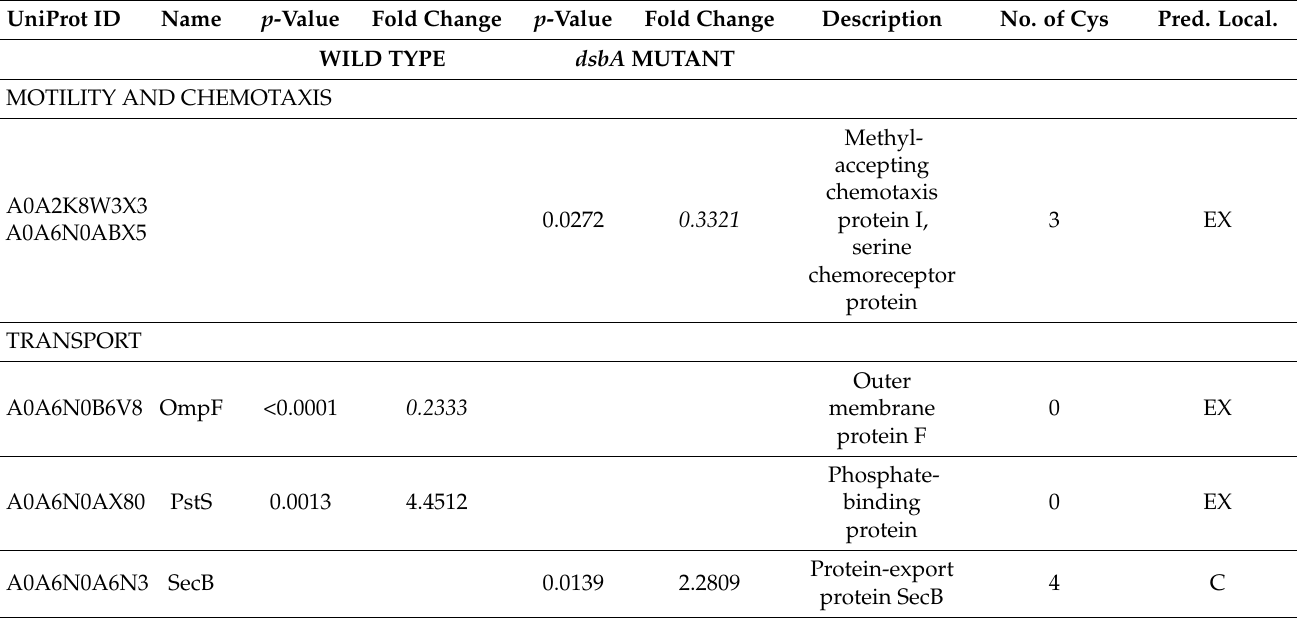
Table 2. The influence of oxidative stress on the proteomes of the D. solani wild-type strain and the derived dsbA